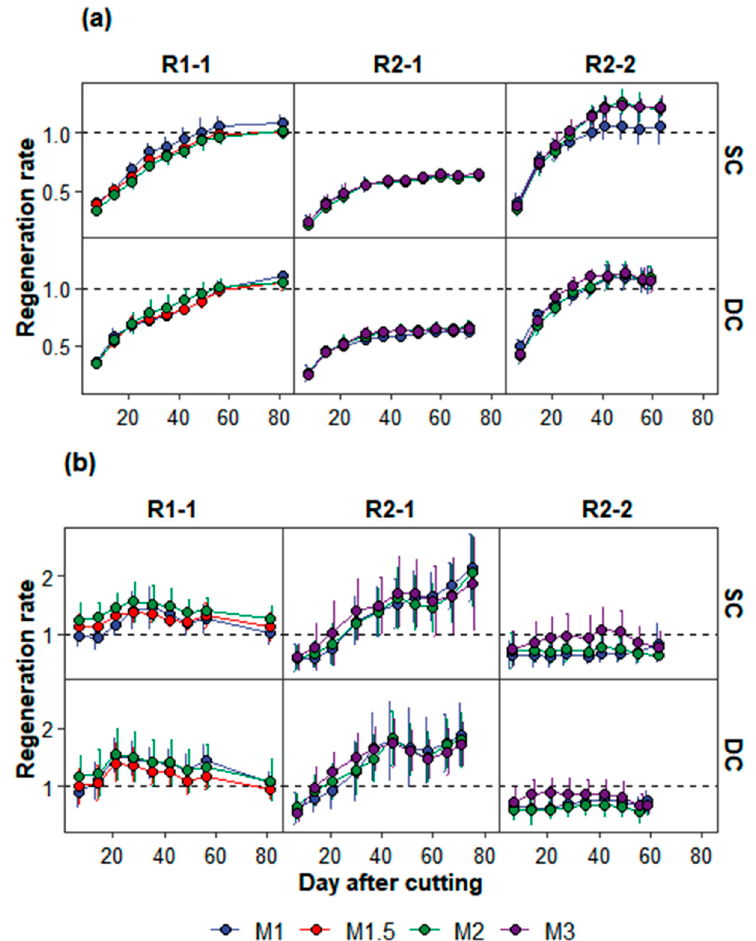
Figure 2. Changes in regeneration rate of ( a ) plant height and ( b ) tillers for each regime and ratoon crop. R1-1, R2-1, and R2-1 represent the first ratoon of the first main crop, first ratoon of the second main crop, and second ratoon of the second main crop, respectively. DC and SC indicate double and single cuttings, respectively. M1, M2, and M3 represent saturated, humid, and dry soil moisture conditions, respectively. Data are mean ± standard error ( n = 16, 4 hills × 4 replications).